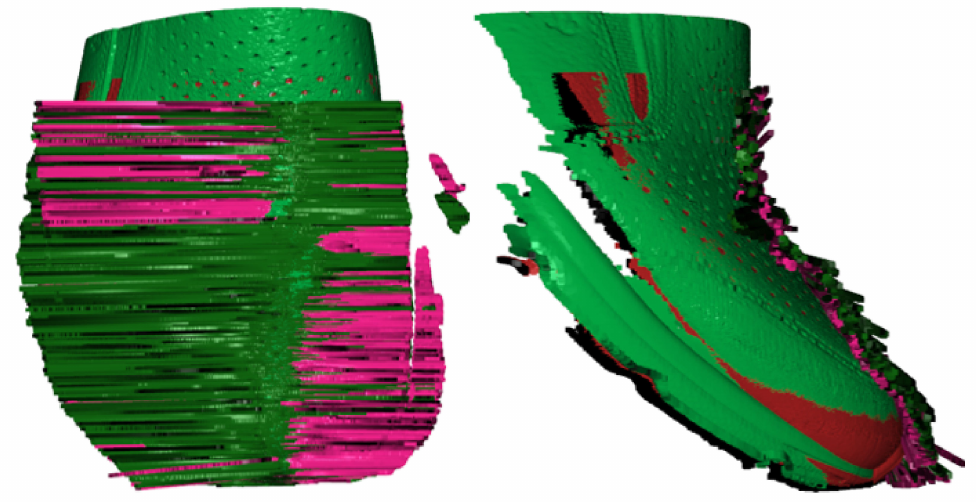
Figure 14. Comparison etalon scan with inspected scan.